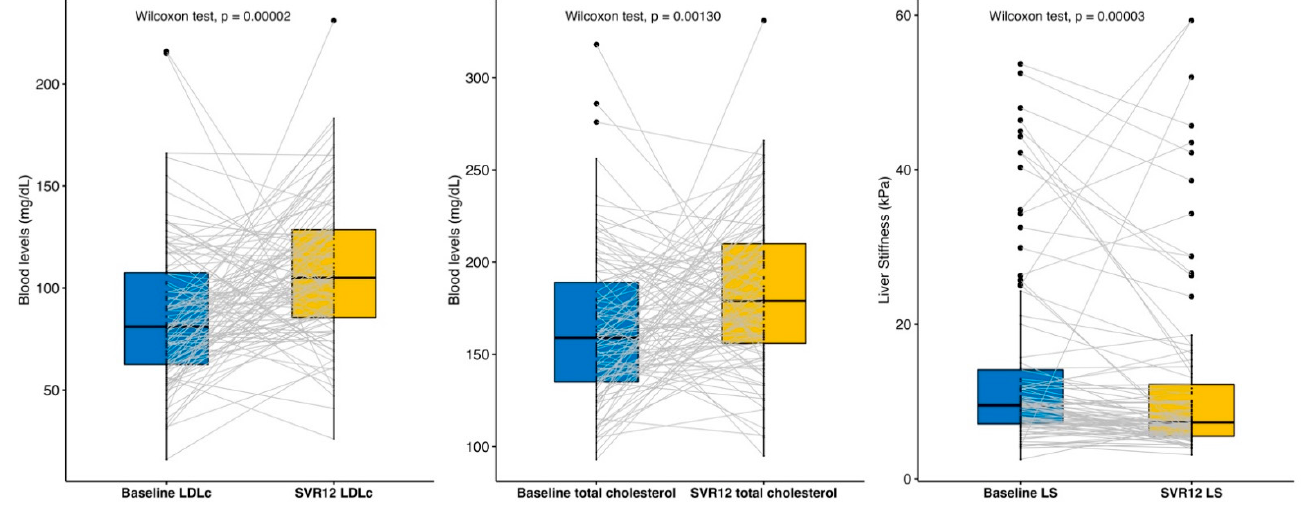
Figure 2. Lipid (LDLc and total cholesterol) and liver stiffness changes baseline versus SVR12. LS: liver stiffness, SVR12: sustained virological response at 12 weeks after treatment, LDLc: low ‐ density cholesterol.